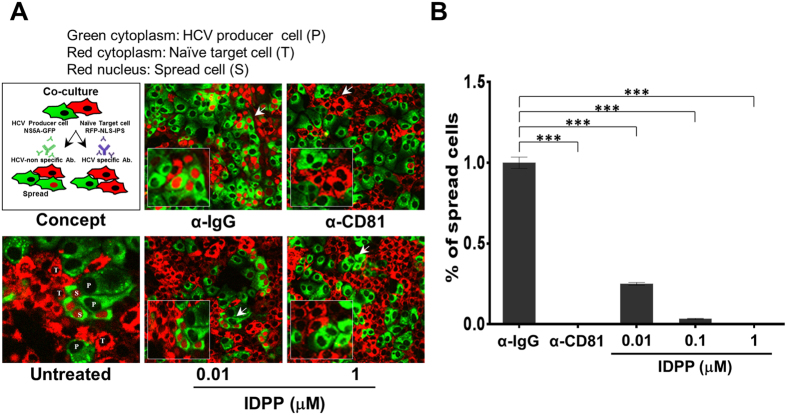
IDPP interferes with HCV cell-to-cell spread.(A) Viral spread assay was performed as described in concept image. After JFH1 (GFP-tagged) infected Huh-7.5 cells (producer cells, P) were co-cultured with naïve TagRFP-NLS-IPS cells (target cells, T), cell-to-cell spread of virus was assessed by counting of red nuclei (spread cells, S) (upper panel). P cells were co-cultured with T cells in the presence of IDPP or α-CD81 mAb (1 μg/mL), and S cells were assessed at 72 h post treatment. (B) S cells were counted and data are shown as the mean ± SD of four independent experiments. ***p < 0.001.